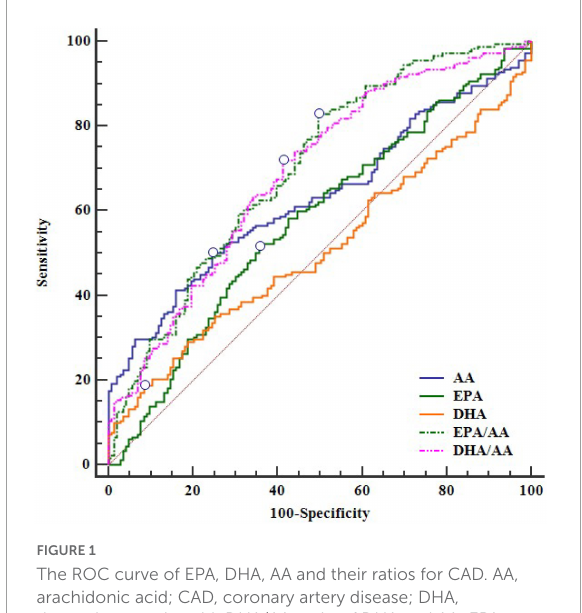
FIGURE1 The ROC curve of EPA, DHA, AA and their ratios for CAD. AA, arachidonic acid; CAD, coronary artery disease; DHA, docosahexaenoic acid; DHA/AA, ratio of DHA and AA; EPA, eicosapentaenoic acid; EPA/AA, ratio of EPA and AA; ROC,